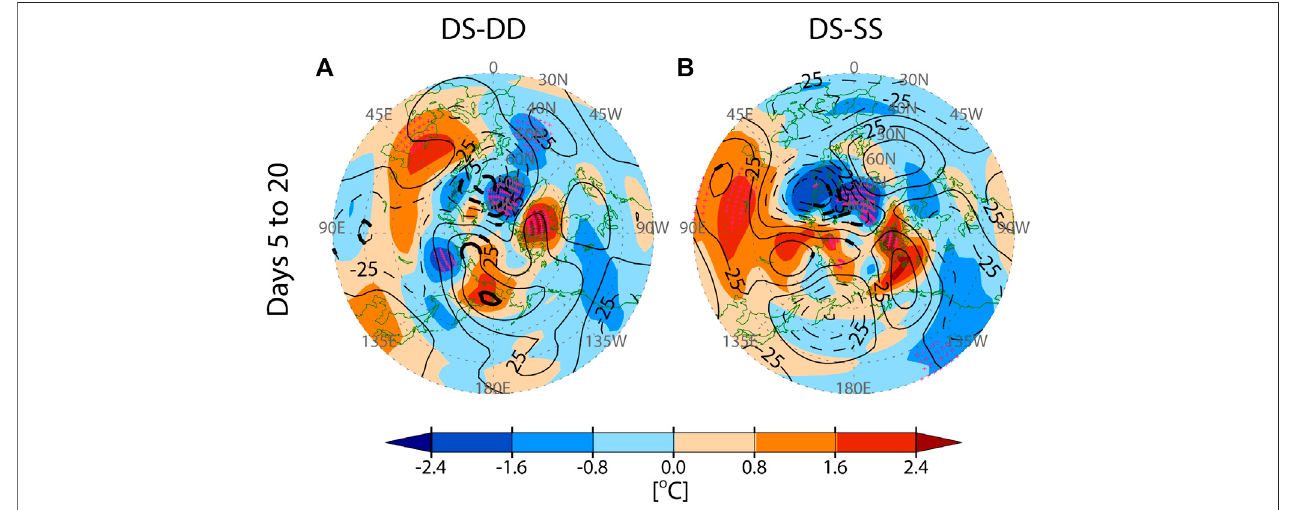
FIGURE2| Differences intemperature anomaly at 1,000 hPa and geopotentialheight (GPH) anomalyat 300 hPa averaged from days 5to20 (A) between DSand DD types, and (B) between DS and SS types. Pink dots and bold contours indicate signi fi cant regions at 90% con fi dence level in temperature difference and GPH difference,